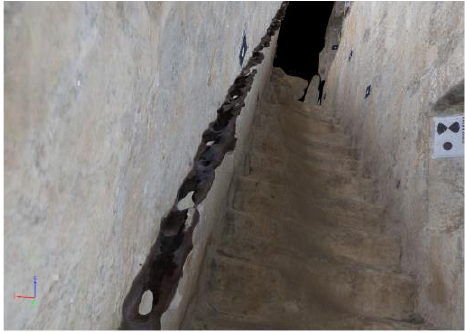
Figure 9: Result of 3D reconstruction in the handrail present, there are problems in given the lack of views in height and depth.